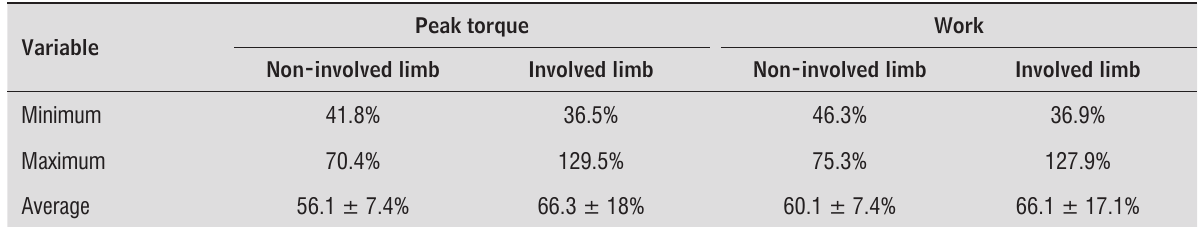
Table 1 - Comparison of the hamstring/quadriceps peak torque ratio: descriptive statistical